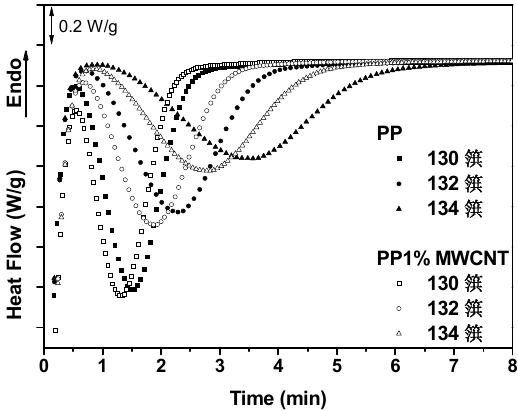
Figure 2. Isothermal DSC results obtained with pure PP and 1 wt.% MWCNT/PP nanocomposite at the indicated